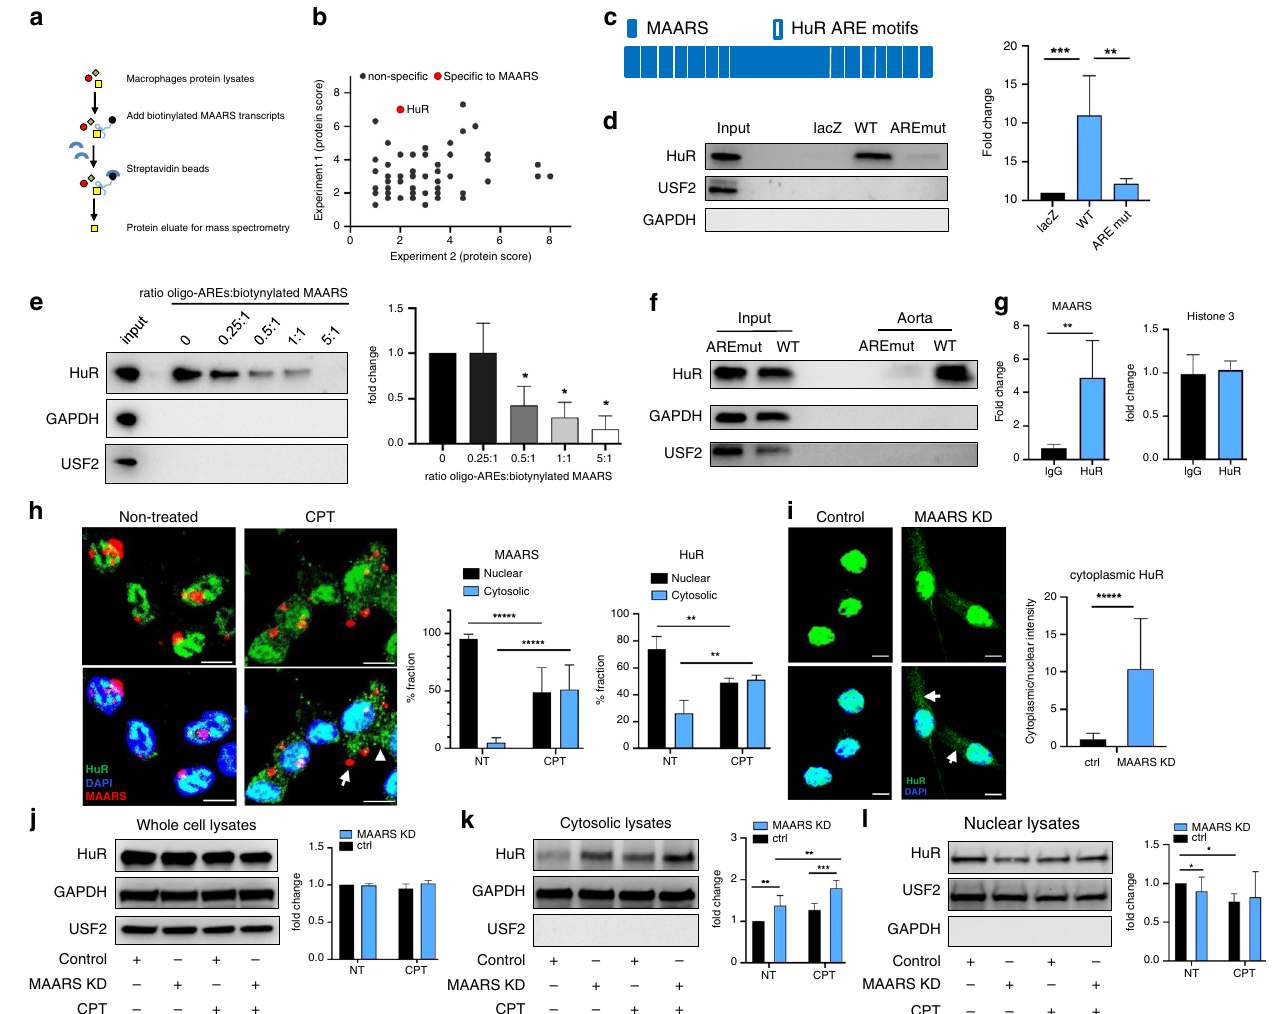
Fig. 4 MAARS interacts with HuR (ELAVL1). a Illustration of lncRNA pulldown using nuclear protein extract from RAW264.7 macrophages for in vitro transcribed biotin-labeled MAARS or negative control LacZ followed by streptavidin beads pulldown. Protein eluate was sent for MS. b Proteins identi fi ed in pulldowns of biotynlated MAARS from two independent experiments, two technical replicates. c Schematic representation of HuR binding motifs to AU-rich elements (ARE) on MAARS transcript. d Biotinylated lncRNA pulldown using MAARS wild type (WT) or MAARS with mutated HuR binding ARE sequences (AREmut) in nuclear lysates of BMDMs ( n = 5). e Competition pulldown using biotinylated MAARS and RNA synthetic AREs oligonucleotides at different picomole ratios ( n = 3). f In vivo lncRNA pulldown using whole cell lysates from aorta of ApoE − / − mice fed HCD following two i.v. injections of biotin- labeled lncRNA transcripts ( n = 2 per group, pooled) . g RNA immunoprecipitation (RIP) in nuclear BMDM lysates using HuR-speci fi c antibody ( n = 3). h BMDM treatment with camptothecin (CPT) induces HuR (arrow head) and MAARS ( arrow) shuttling from the nucleus to the cytosol. Representative images and quanti fi cation of cytosolic and nuclear HuR and MAARS staining in BMDM treated with or without camptothecin (CPT, 20 µ M) for 1 h ( n = 3, 200 cells quanti fi ed per condition). i HuR cytosolic (white arrows) and nuclear staining was quanti fi ed in confocal microscopy images of BMDMs transfected with control or MAARS gapmeRs ( n = 3, 100 cells quanti fi ed per condition). j Quanti fi cation of Western blots of HuR in whole cell lysates from BMDMs transfected with control or MAARS gapmeRs treated with or without CPT (20 µ M, 1 h). Expression of HuR in cytosolic ( k ) and nuclear fractions ( l ) from BMDMs transfected with control or MAARS gapmeRs treated with or without CPT (20 µ M, 1 h) ( n = 6, values are mean ± SD). For all panels values are mean ± SD. * p < 0.05; ** p < 0.01; *** p < 0.001; ***** p <